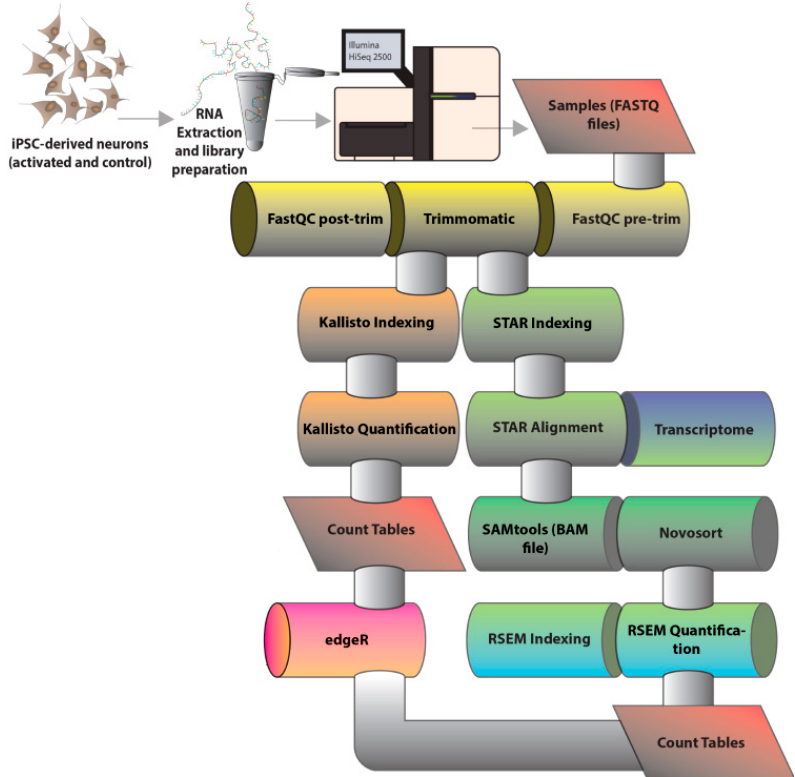
Figure 1. Bioinformatics pipeline for RNA-Sequencing (RNA-Seq) analysis. The figure schematically shows the steps for RNA-Seq analysis. After paired-end reads were generated by sequencing total RNA from human induced pluripotent stem cells (iPSC)-derived neurons using the Illumina HiSeq 2500 platform (Illumina, San Diego, CA, USA) and delivered as FastQ files. Bioinformatics tools were used to perform quality control (FastQC, version 0.11.5) [28] and adaptor trimming (Trimmomatic, version 0.36 [29]). From this point, reads were submitted to two parallel methods of transcript abundance estimation: an alignment-independent method where reads are simultaneously pseudoaligned and counted by Kallisto (version 0.43.0) [30]; and an alignment-based strategy where reads are first aligned